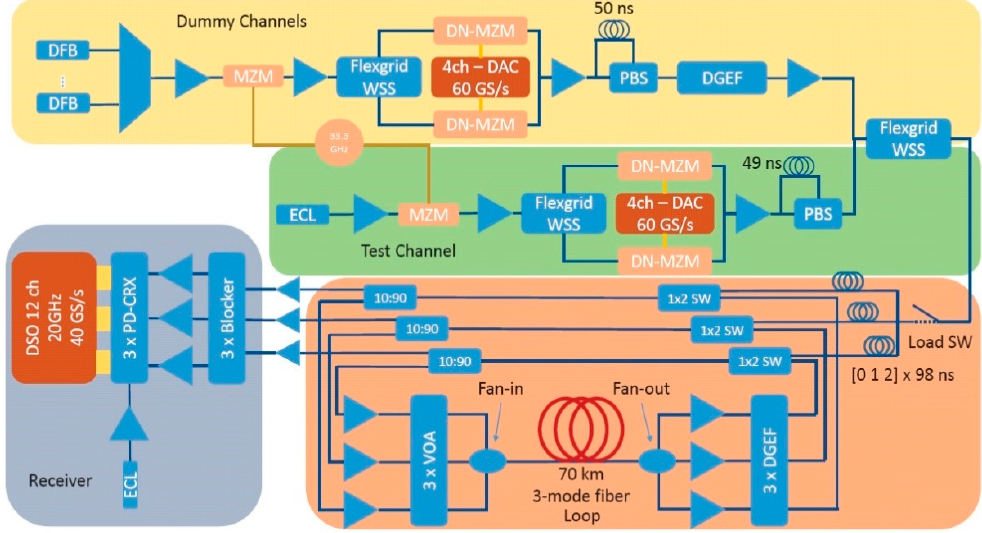
Figure 36. Setup of a 6 × 6 MIMO-based transmission [49].